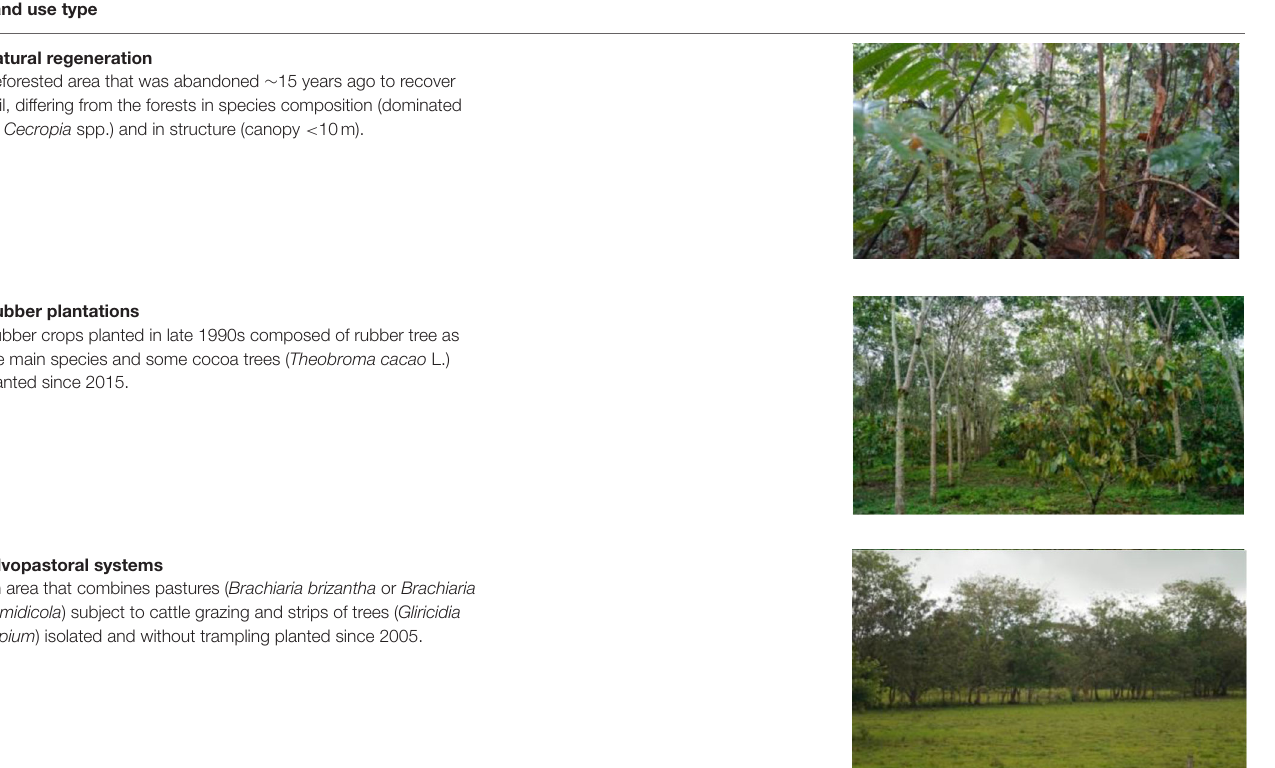
TABLE 1 | Description of land use types evaluated; the photos are representative of the sampled